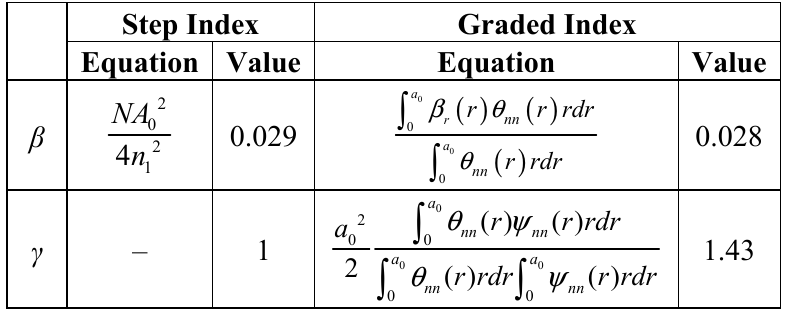
Table 1. Expressions and typical values of the parameters β and γ for step-index (SI) and graded index (GI) POFs. The notation employed is explained in